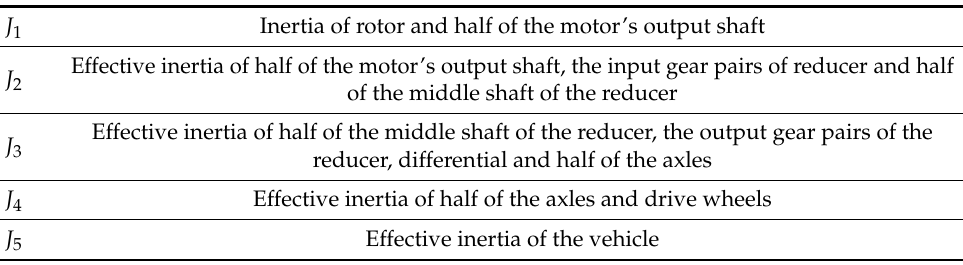
Figure 20. 5-Degree of Freedom (DOF) torsional vibration model of the driveline. Table 2. Inertia moments in the driveline model.